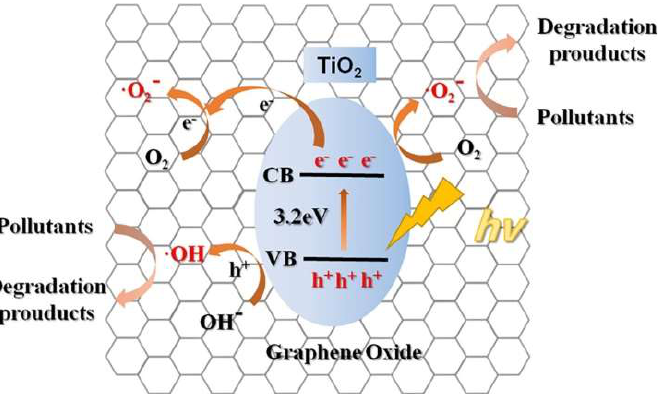
Figure 6. Mechanism of the degradation of xanthate (Reproduced from Chem. Eng. J. 2022, 431 with permission from Elsevier) [15].